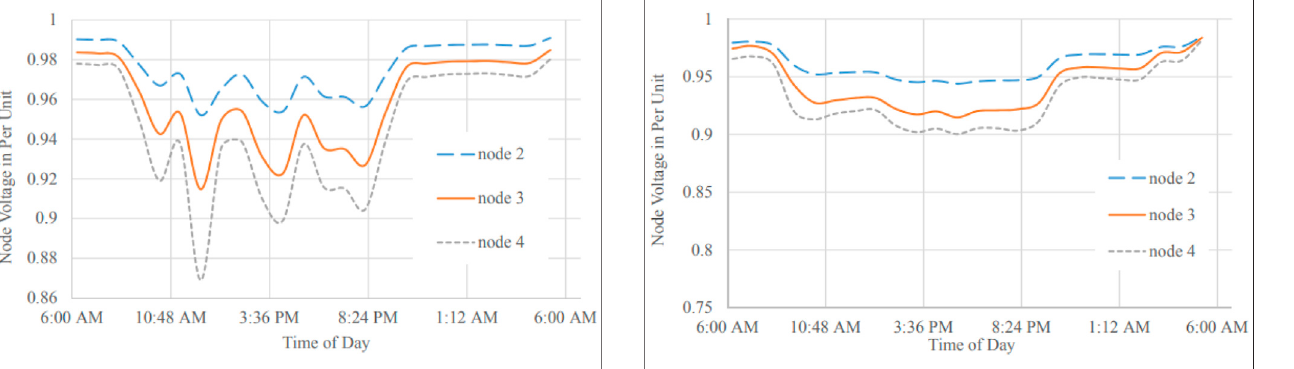
FIGURE 6 | Without rescheduling, node voltages for utility forecast 01.